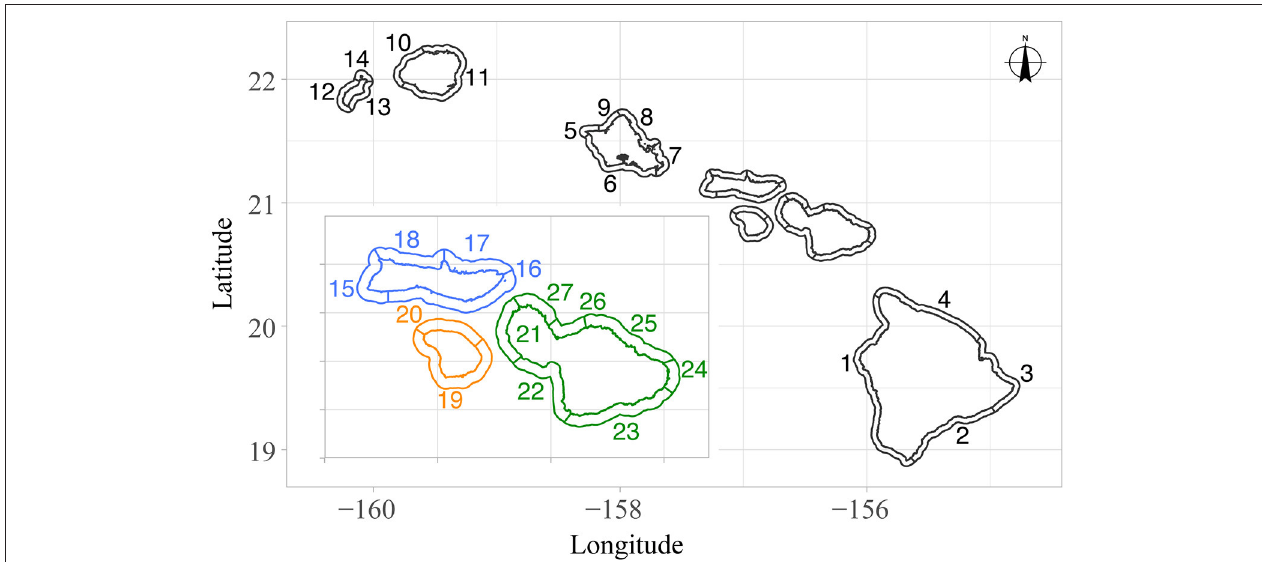
FIGURE 1 | Sub-island sectors of the main Hawaiian Islands, used in the NOAA Pacific Reef Assessment and Monitoring Program’s survey design, as well as in our hierarchical analysis. Sector names, as they appear in the text, include: 1, Hawaii-Kona; 2, Hawaii-Southeast; 3, Hawaii-Puna; 4, Hawaii-Hamakua; 5, Oahu-Kaena; 6, Oahu-South; 7, Oahu-East; 8, Oahu-Northeast; 9, Oahu-Northwest; 10, Kauai-Na Pali; 11, Kauai-East; 12, Niihau-West; 13, Niihau-East; 14, Niihau-Lehua; 15, Molokai-West; 16, Molokai-South; 17, Molokai-Pali; 18, Molokai-Northwest; 19, Lanai-South; 20, Lanai-North; 21, Maui-Lahaina; 22, Maui-Kihei; 23, Maui-Southeast; 24, Maui-Hana; 25, Maui-Northeast; 26, Maui-Kahului; 27, Maui-Northwest. Note that sector widths are not to scale (i.e., the sampling domain for fish surveys only extends from the shoreline to 30m